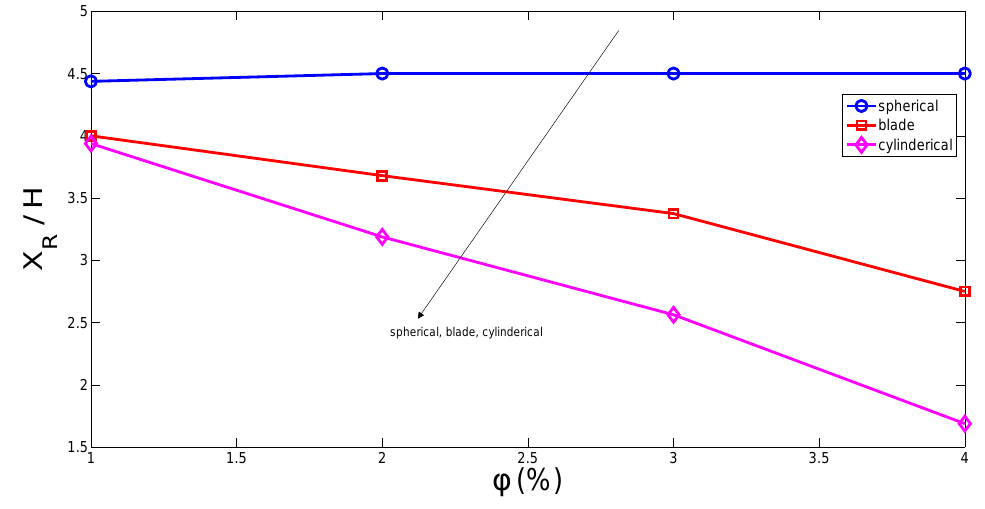
Figure 2. Particle size effect on the reattachment length for various nanoparticle volume